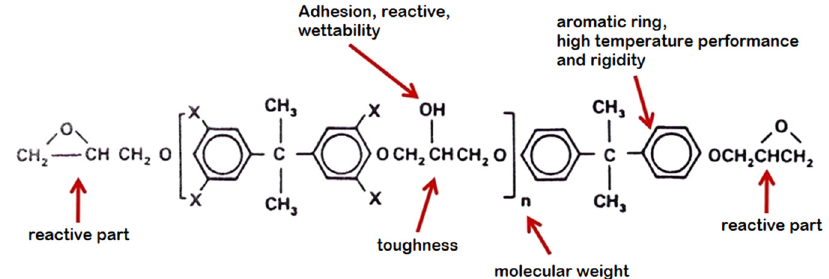
Figure 11: Parts or situses of a compound constructing epoxy DGEBA monomer [ 57 ] .